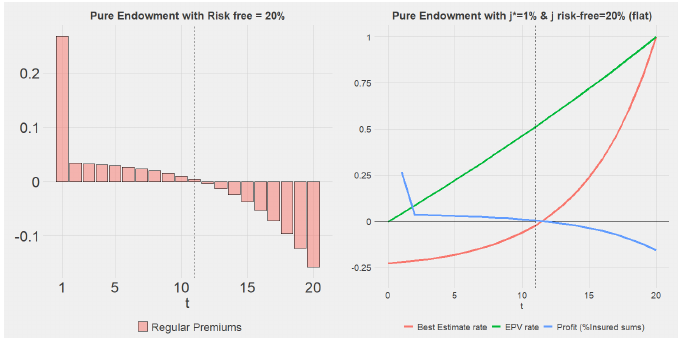
Figure 4. Expected demographic profit in the Pure Endowment with higher risk-free rates.